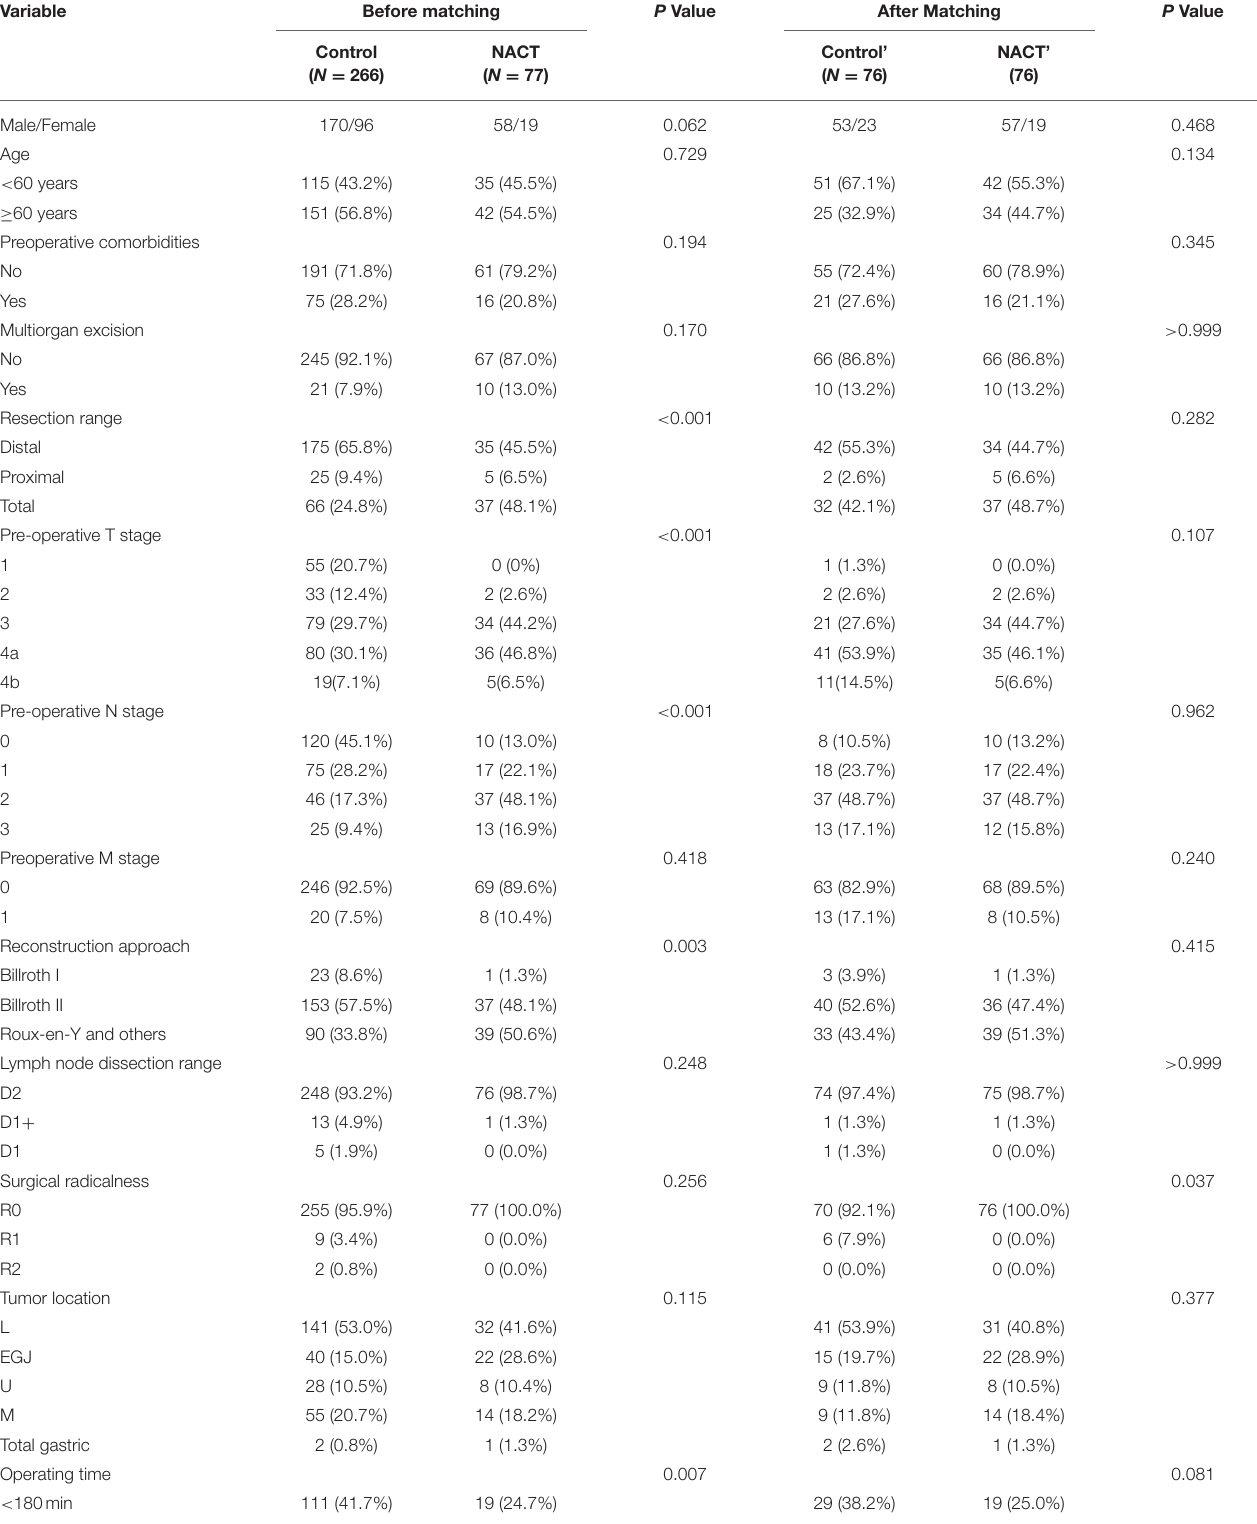
TABLE 1 | Clinical characteristics of the two groups before and after